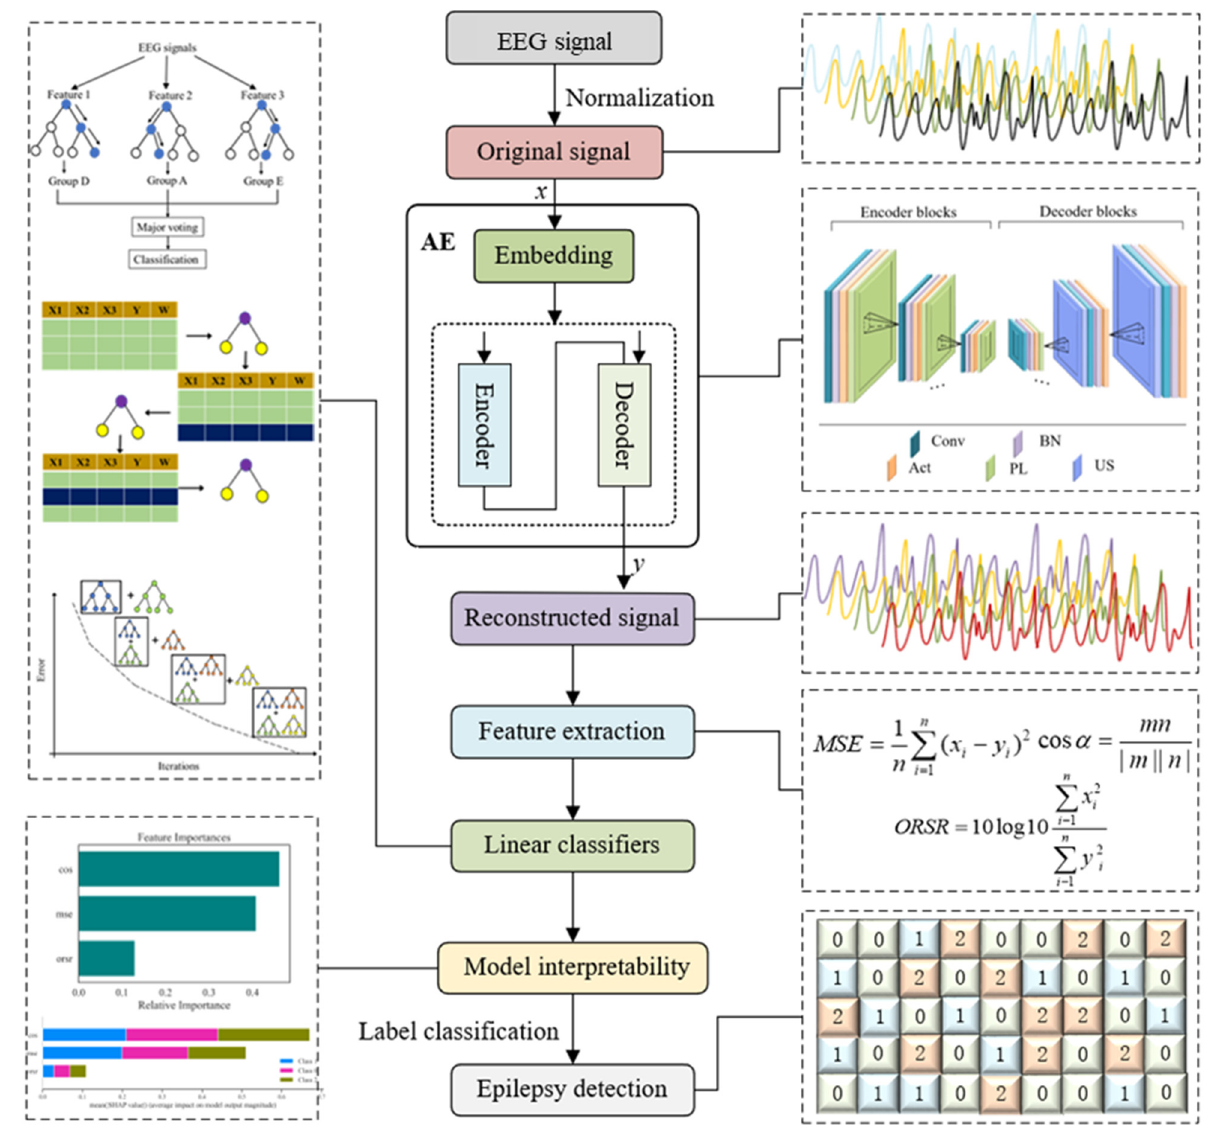
Figure 1. Flowchart of this research.